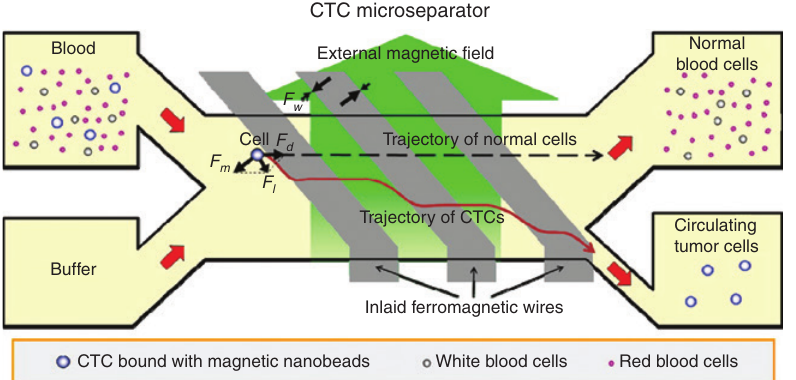
Figure 3: Separation of CTCs based on antibody-immobilized magnetic nanobeads and a microfluidic device. A model CTC line – breast cancer cell lines (SKBR-3) – were spiked into human peripheral blood. The sample was mixed with anti-EpCAM antibody-modified mag- netic nanobeads. Two syringe pumps were used to inject the blood sample and PBS buffer into the two inlets. Application of magnetic field through inlaid ferromagnetic wires caused deviation of CTCs from trajectory of normal cells, and CTCs could be directed into another channel (Reproduced with the permission of the publisher, American Chemical Society, Copyright 2013, from Ref.